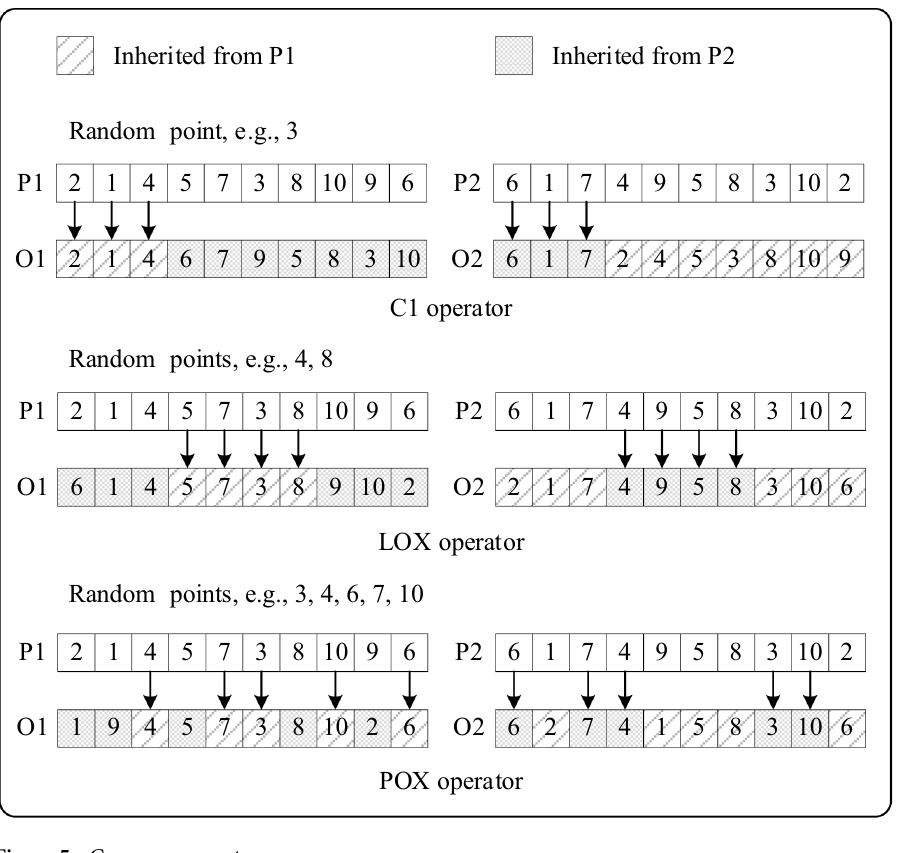
Figure 5. Crossover